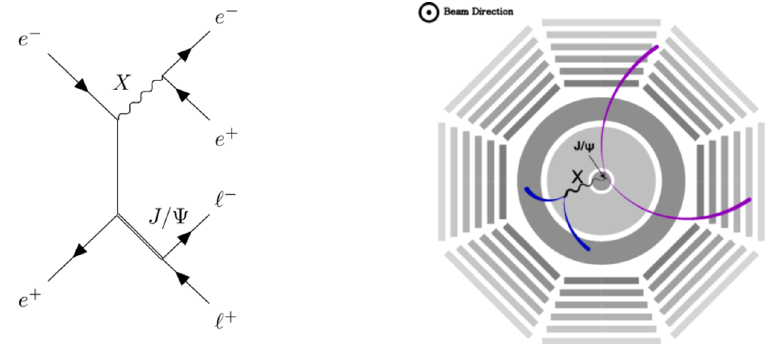
Figure 6 . (Left panel) The Feynman diagram of the e + e − → X + J/ Ψ → e + e − ‘ + ‘ − signal. (Right panel) The schematic picture of the decay process of the long-lived X boson in the Belle II detector.